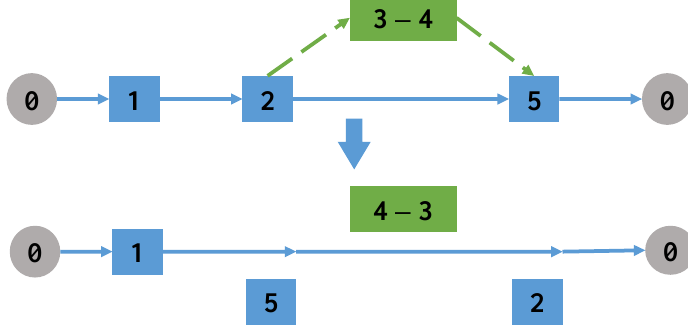
Figure 3. Change the direction of the tasks.